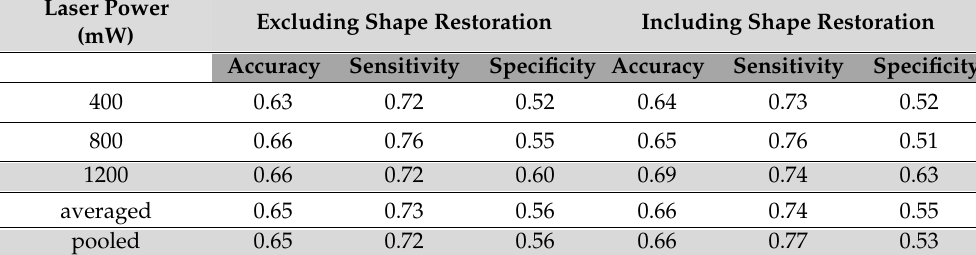
Table 2. Prediction performance of the random forest machine learning algorithm. The algorithm was applied to our optical stretcher data set of 3641 non-hematopoietic cells from breast cancer patients and 2541 PBMC. Cells were tested in step stress experiments at various laser powers, and physiological parameters and cellular deformation were recorded. Kelvin–Voigt modeling was applied to the data to derive a number of active and passive rheological parameters. The prediction power slightly increased from 400 mW over 800 mW to 1200 mW. When data from all three laser powers were pooled before applying the RF algorithm, accuracy was 0.65, sensitivity and specificity were 0.73 and 0.56, respectively. Interestingly, when shape restoration/relaxation was included, accuracy, sensitivity and specificity increased to 0.69, 0.74 and 0.63, respectively, at the highest laser power.